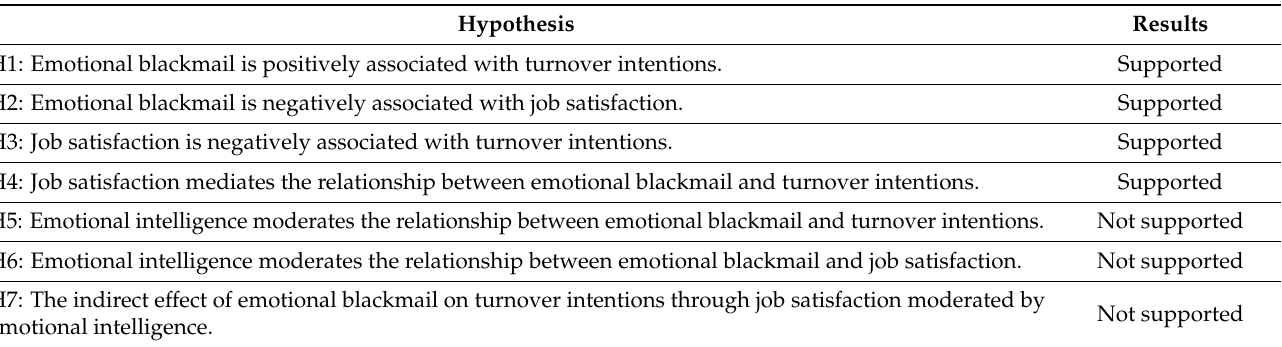
Figure 2. Moderating effect of emotional intelligence on the relationship between emotional blackmail and turnover intentions. Table 7. The results of the hypotheses.